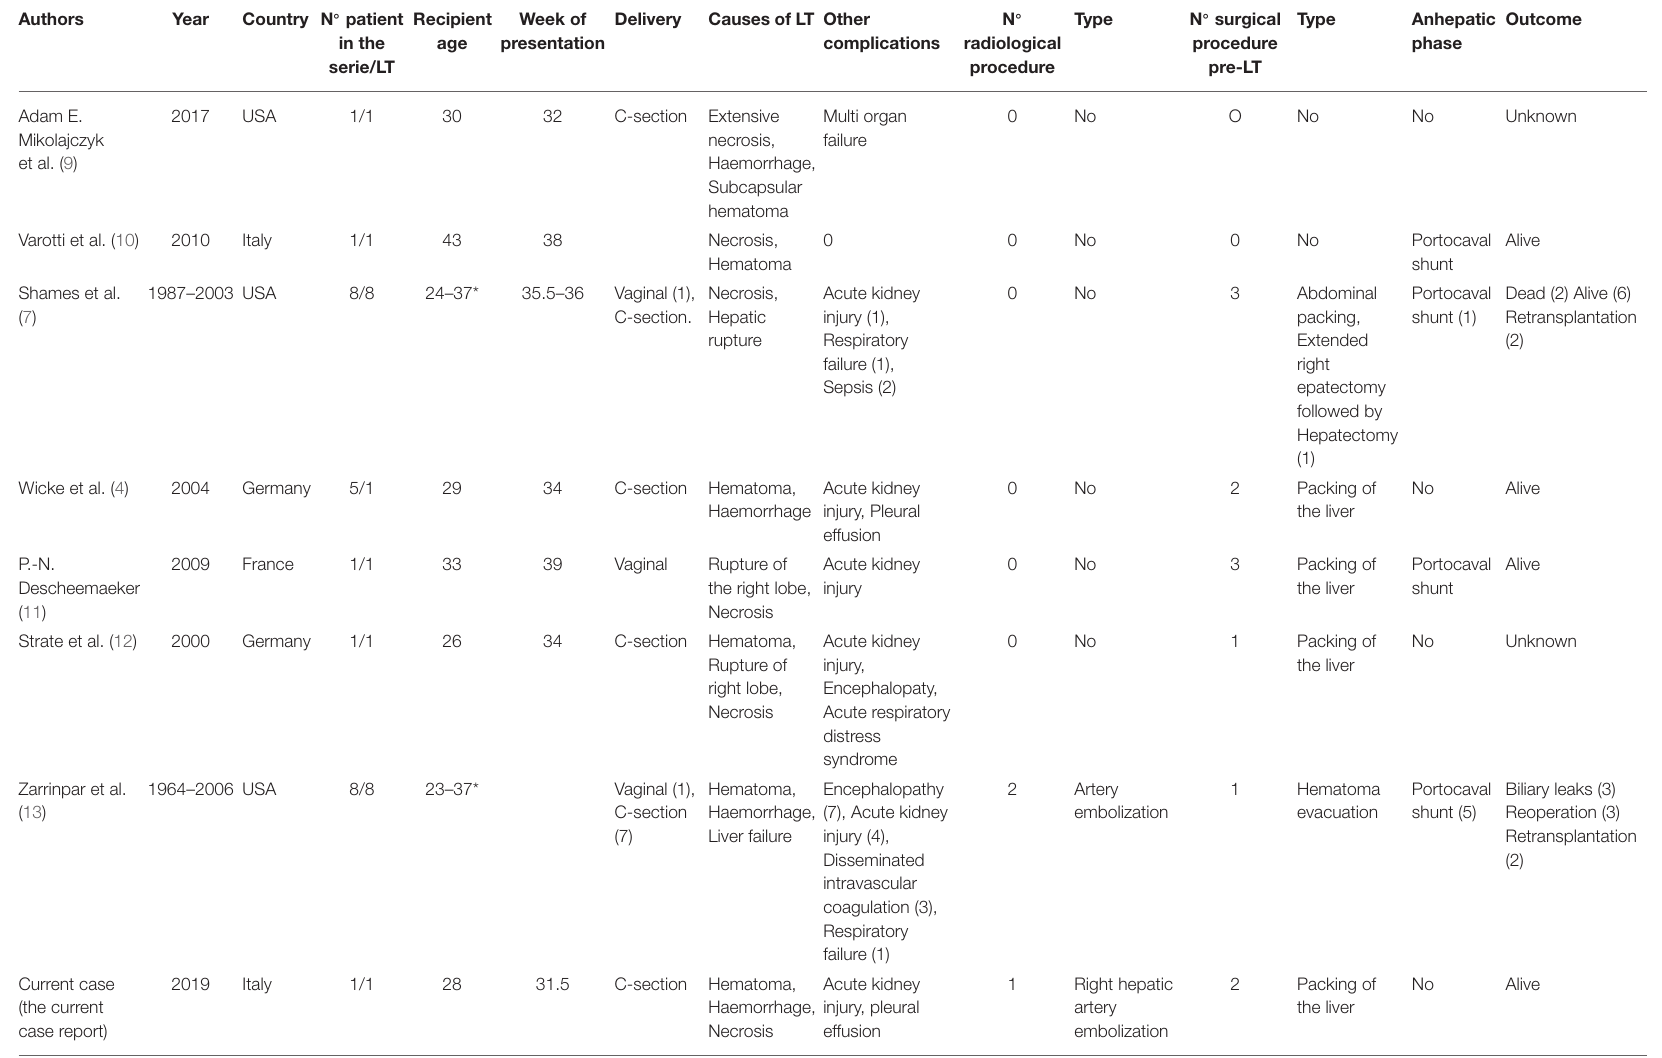
TABLE 2 | Summary of the published articles reporting cases of liver transplantation due to liver rupture or ischaemia due to HELLP syndrome.